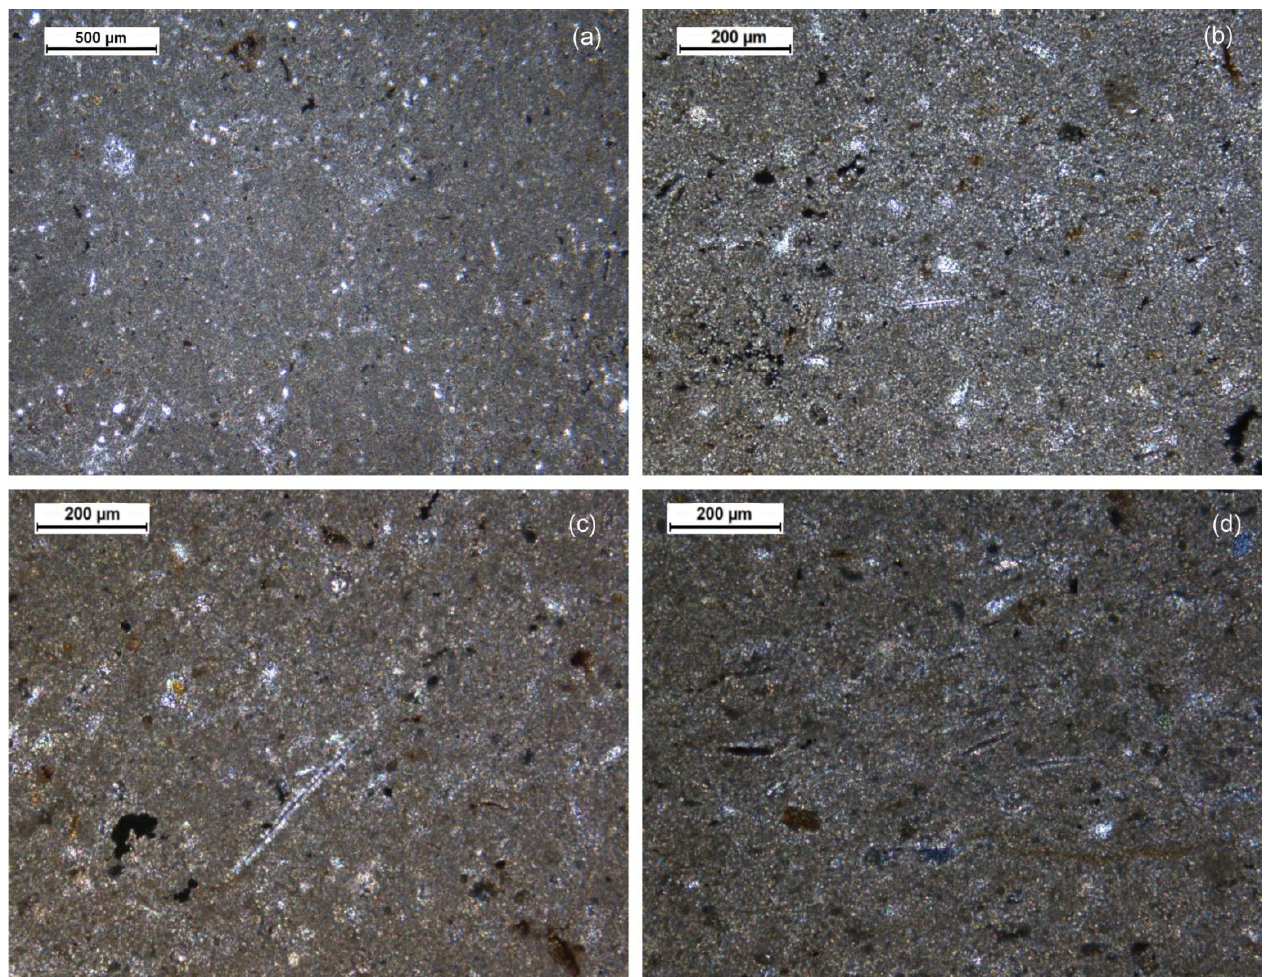
Figure 5. Optical polarised light microscope microphotographs ( a – d ): ( a ) structure 5; ( b ) structure 14; ( c ) structure 20; ( d ) structure 42, rim.